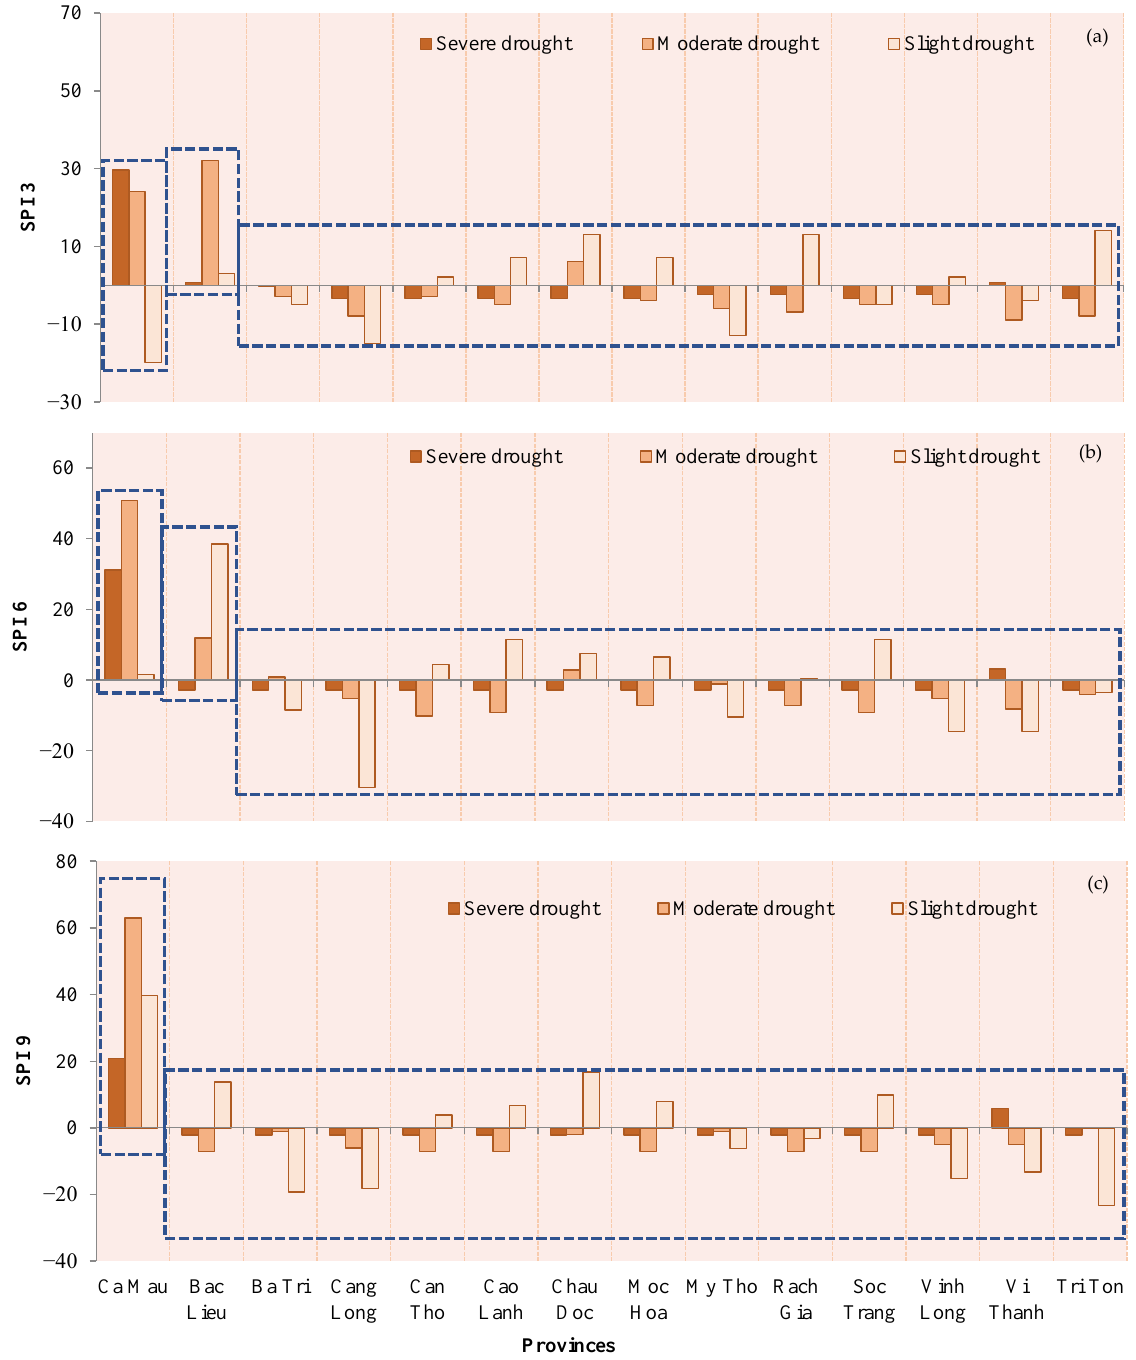
Figure 2. Number of occurrence events of various droughts at SPI 3 ( a ), SPI 6 ( b ), and SPI 9 ( c ) over 14 meteorological stations in the VMD.